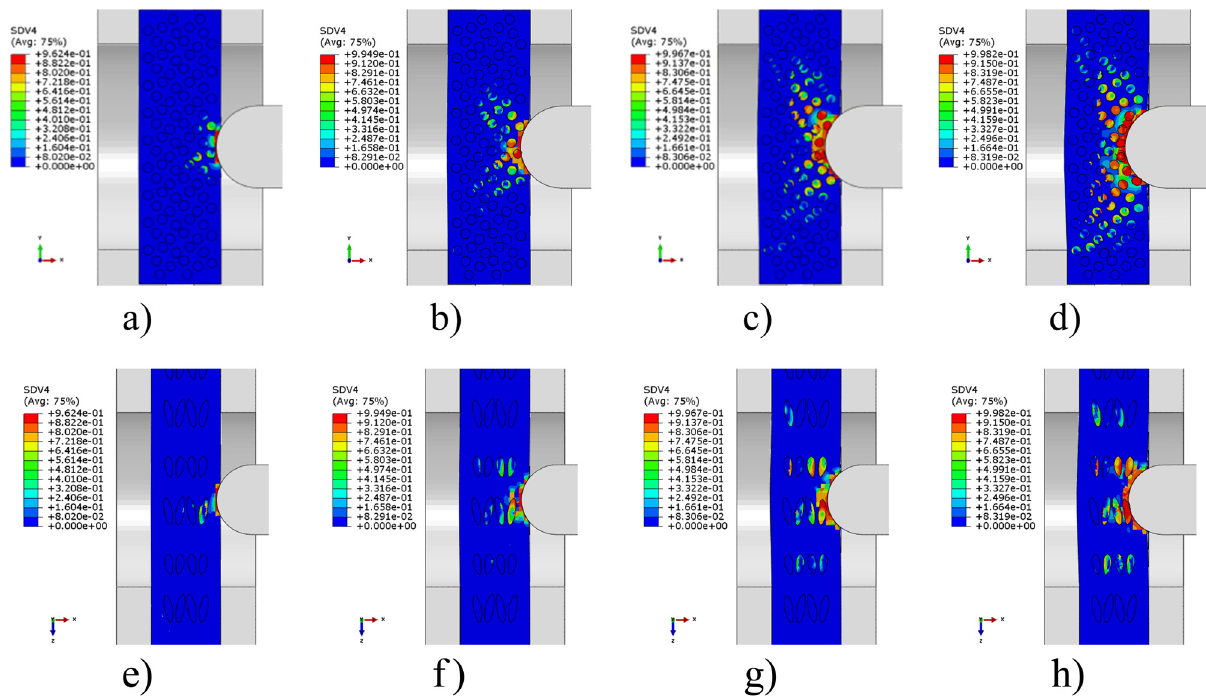
Figure 18: Lateral compressive damage to fi ber bundles and matrix: ( a – d ) fi ber bundles, ( e – h )